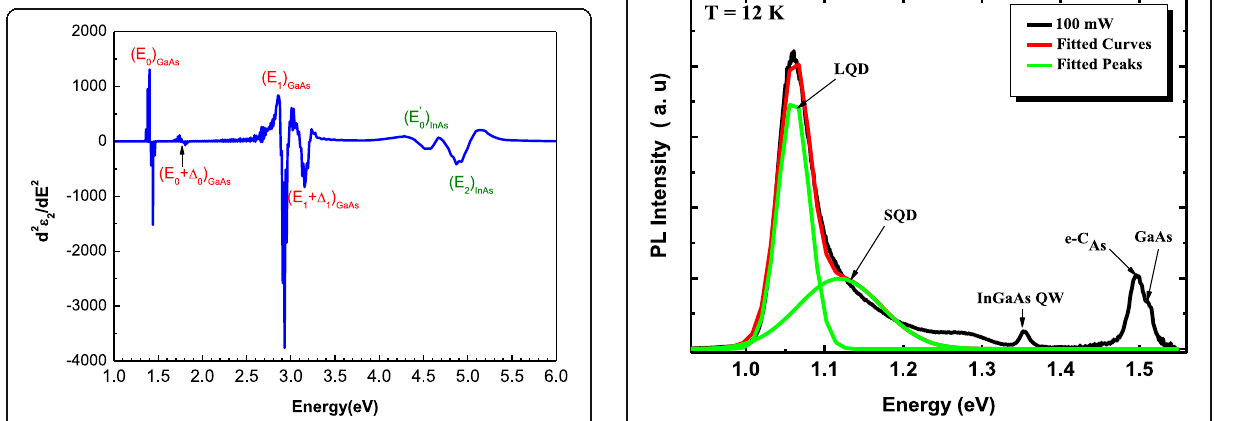
Fig. 4 PL spectrum measured at low temperature (12 K) from the five-layer stacked InAs/InGaAs QD heterostructure. A line shape analysis of spectra proves that the QD PL signal is a convolution of two Gaussian-shaped peaks as shown by solid